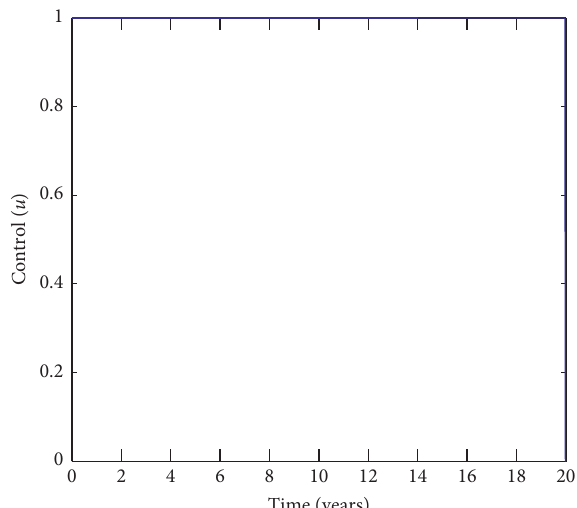
Figure 4: Time series plot showing the effects of the optimal control u . Table 3: The total number of newly infected individuals for 20 years and the total costs concerning the rate of relapse. k (relapse rate) The total cost ( J ) The number of new infections ( I 0.0 1 . 5240 × 10 4 0.2288